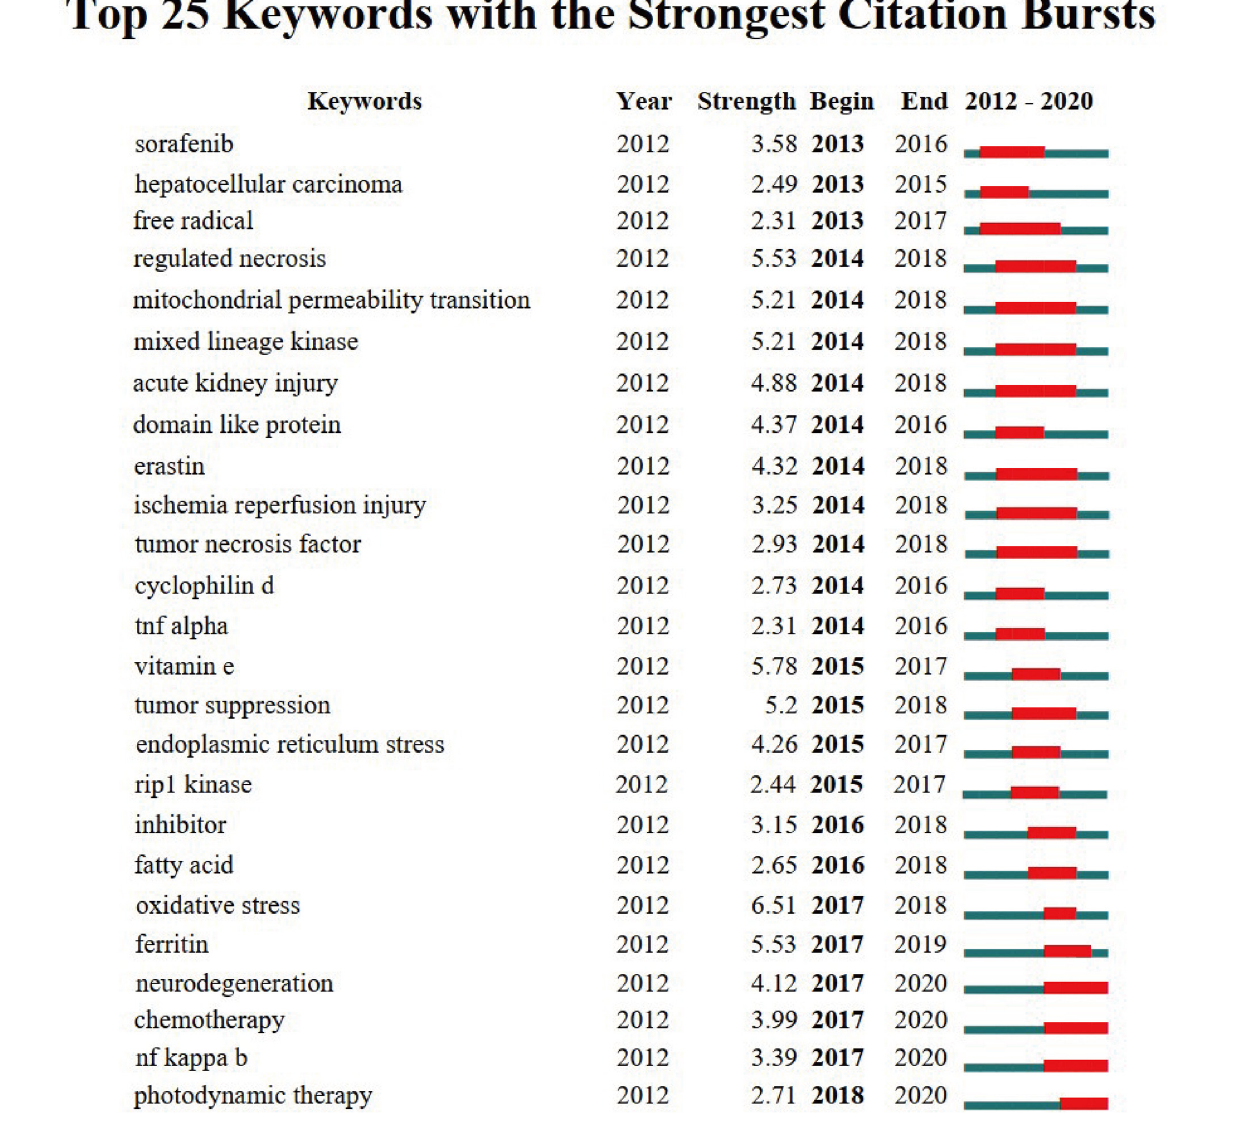
FIGURE 10 | The top 25 keywords with the strongest citation bursts of publications on ferroptosis